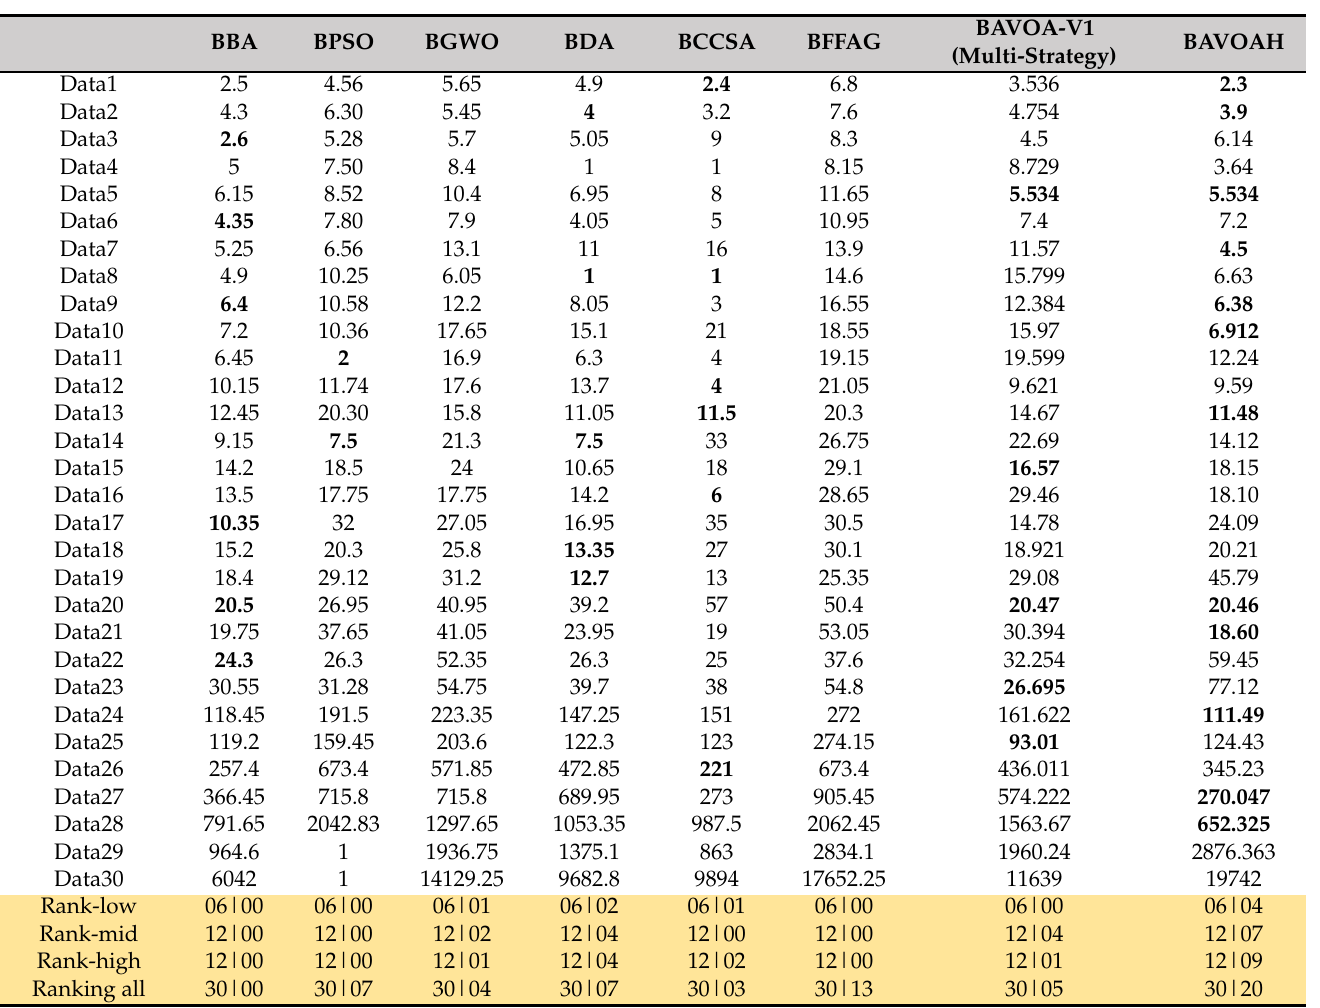
Table 7. Comparison of proposed BAOVAH (hyper-heuristic) and BAVOA-V1 (Multi-strategy), an approach based on the criterion of the average number of